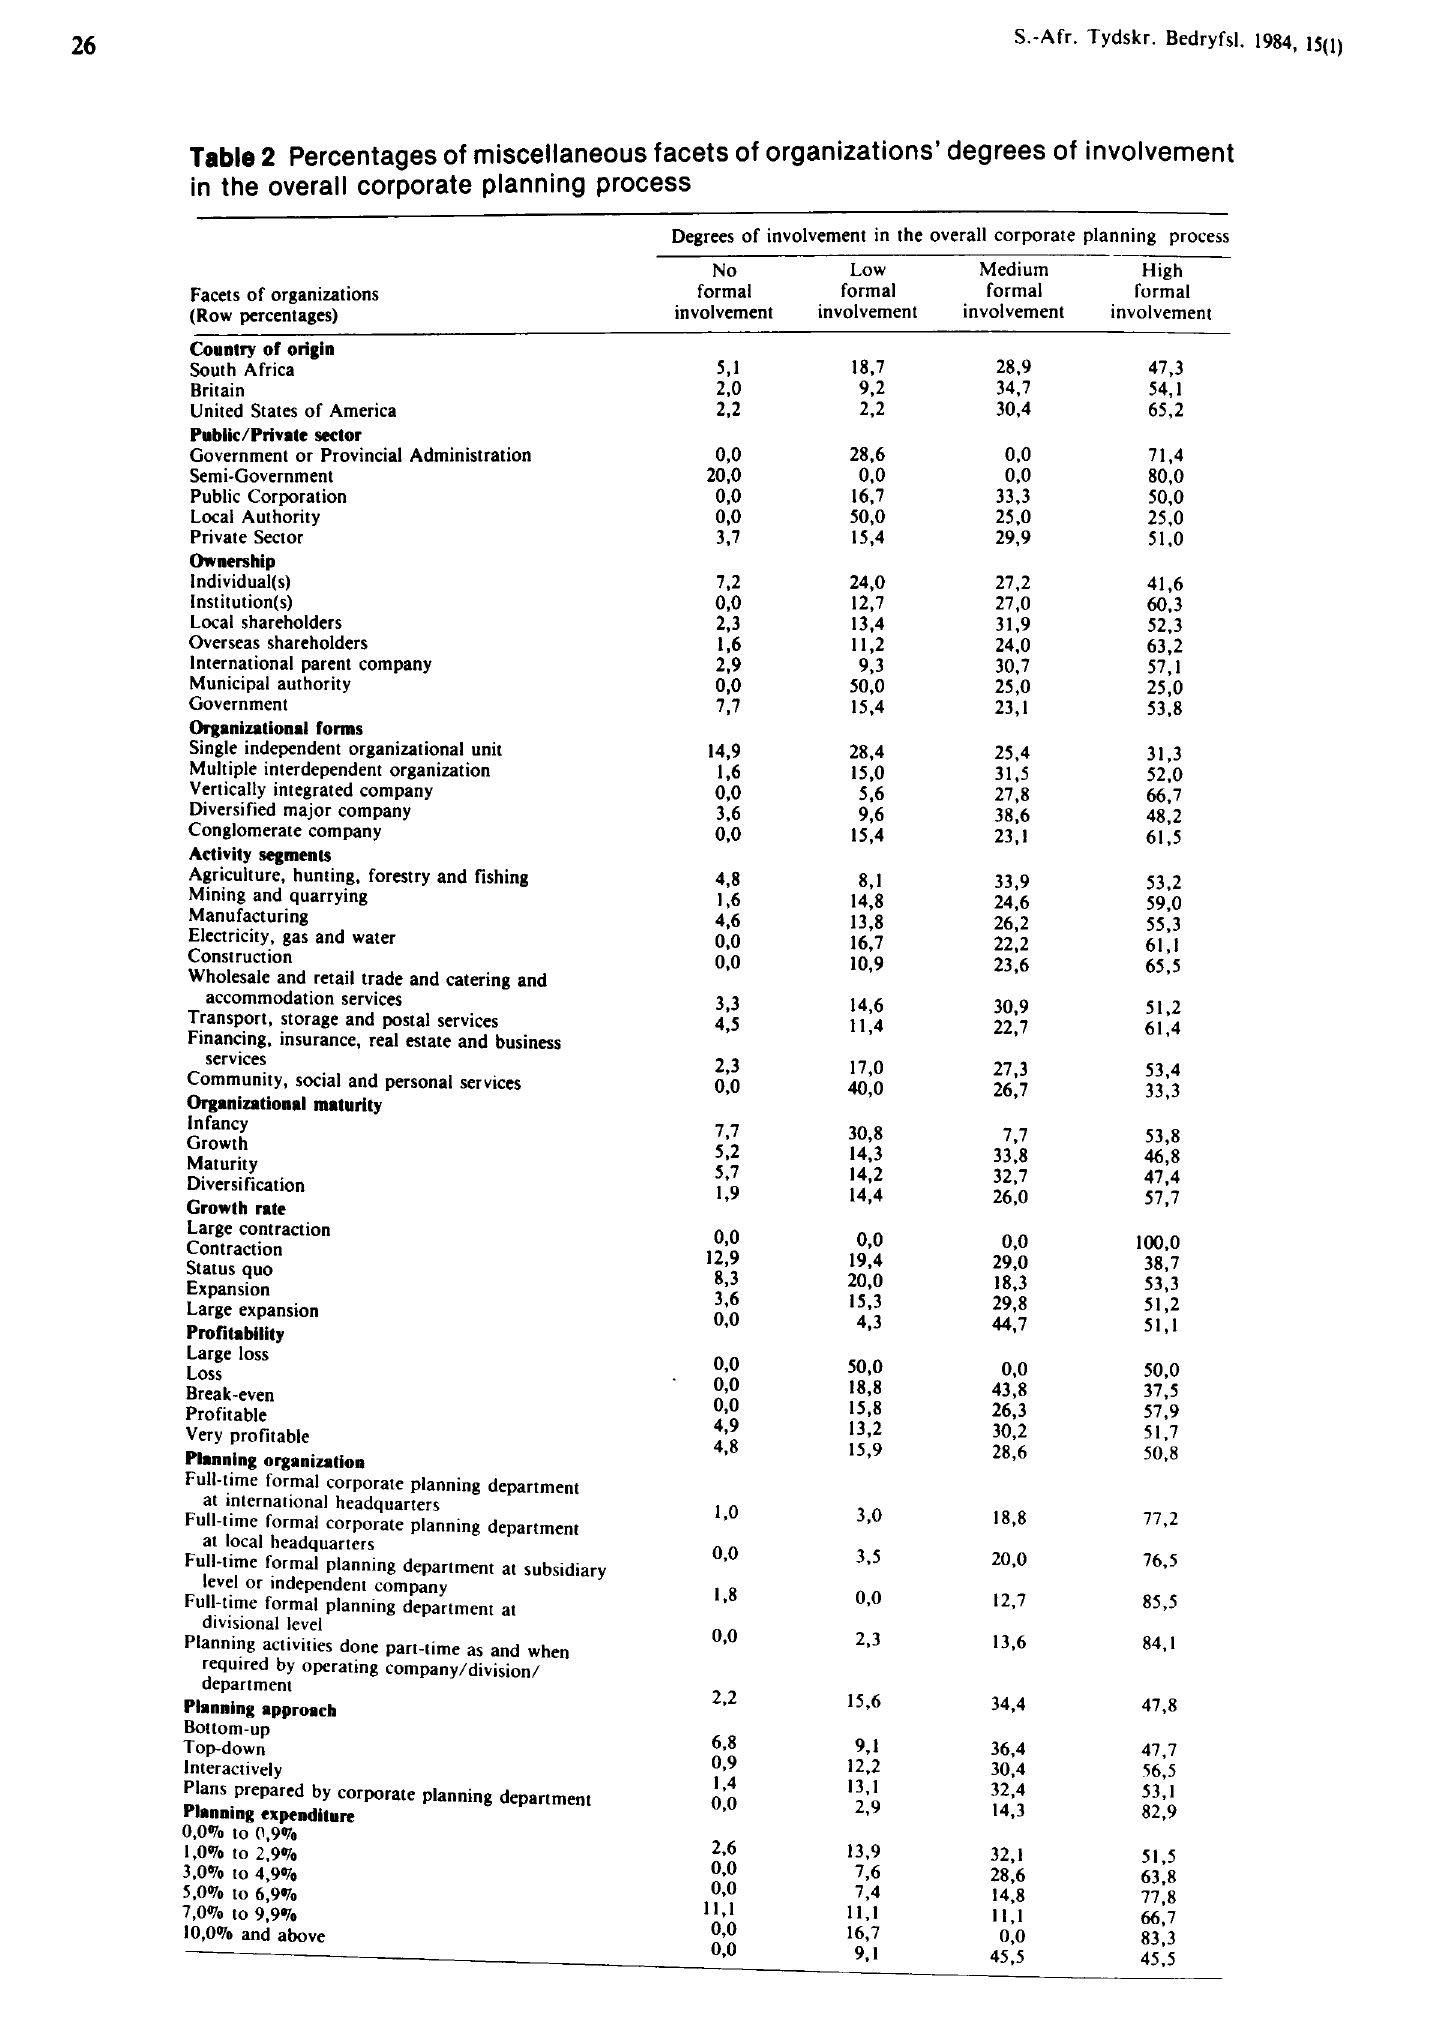
Table 2 Percentages of miscellaneous facets of organizations' degrees of involvement in the overall corporate planning